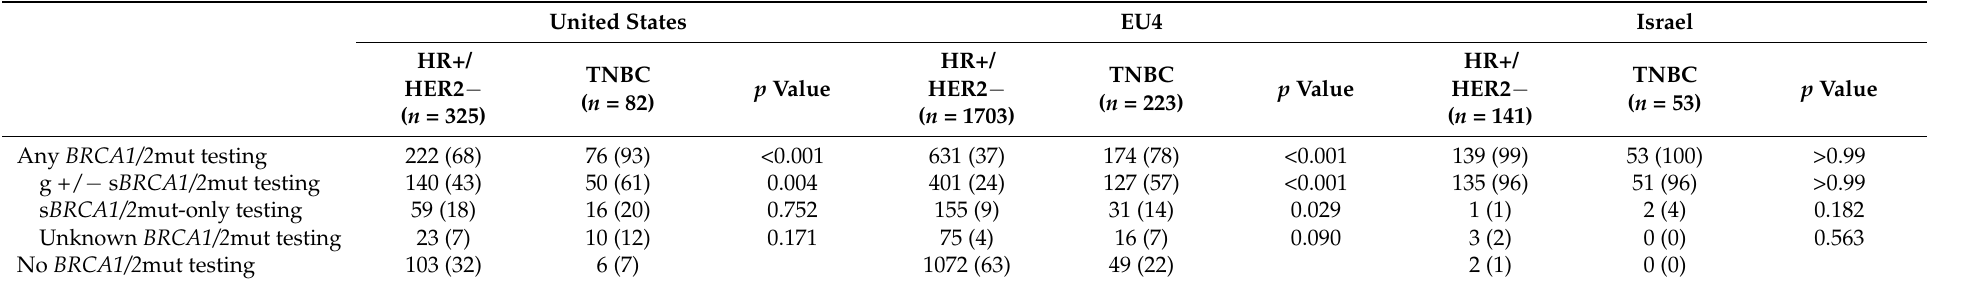
prostate, pancreatic, gastric, and/or fallopian tube cancer. Table 2. BRCA1/2 mut testing rates by HR status among patients with HER2– ABC in the United States, the EU4, and